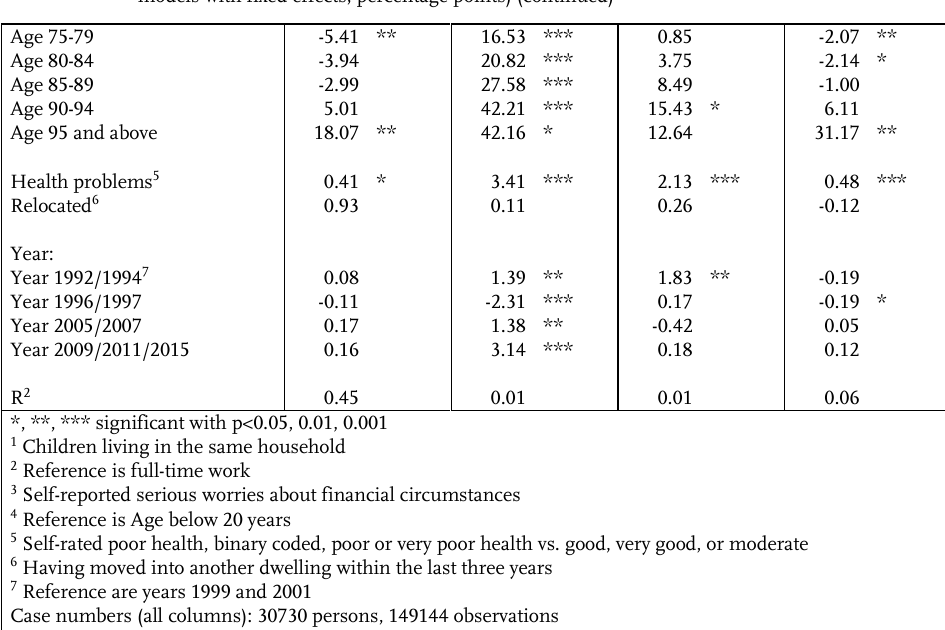
Table A.7 : Time-effects of relationship endings on different types of social isolation (from linear-probability models with fixed effects, percentage points)